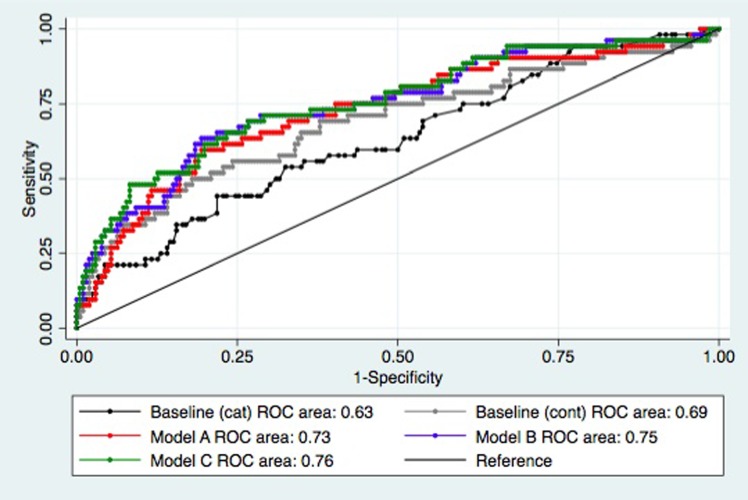
Receiver operator characteristic curve comparison.Demonstrating model performance in predicting adverse pregnancy outcome (APO) for the baseline and proposed models (see Table 3 for model components) in N = 258* pregnancies, of whom 52 (20.2%) experienced APO. The proposed models were superior to the baseline models (p<0.05). AUC = area under receiver operating characteristic curve. * maternal blood sample unavailable in 36 cases, amniotic fluid index measurement unavailable in 2 cases.